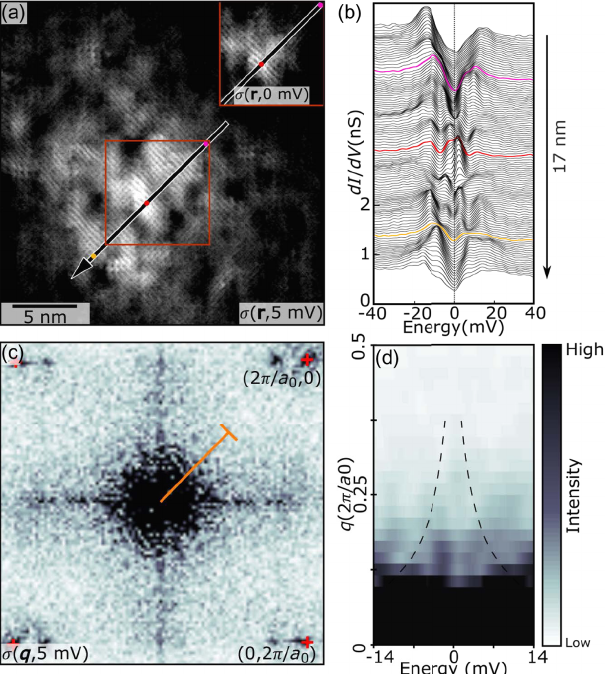
FIG. 2. Electronic structure of a vortex core on heavily OD Bi2212 ( T c ≈ 52 K) at 0.16 Tesla. (a) Low-energy conductance map σ ð r ; 5 mV Þ showing the core of vortex 1 in Fig. 3. The region outlined in red is imaged at 0 mV in the inset to identify the vortex center (red dot). (b) Differential tunneling conductance spectra measured along the trace through the vortex center in panel (a) (the scale corresponds to the bottom spectrum; other spectra are offset for clarity). The pink and orange spectra delimit the core region where the superconducting coherence peaks are suppressed. (c) Fourier transform of panel (a), where only the lattice peaks at q 0 and features related to the superstructure are resolved. (d) Energy dependence of the Fourier amplitude along the orange trace in panel (c). Note the absence of any character- istic structure. Dashed lines are guides to the eye, where a dispersive feature is seen at a high field.